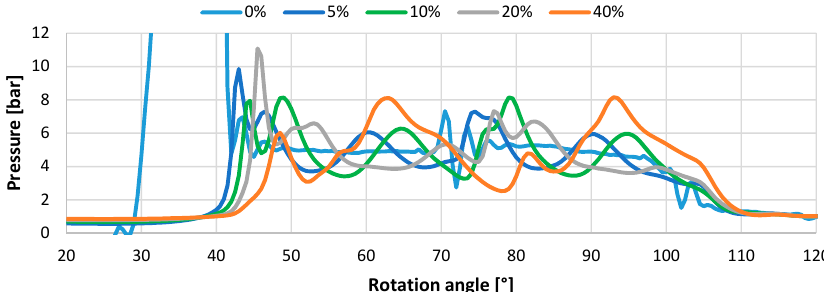
Figure 27. Instantaneous displacement chamber pressure profiles for different IGVF of free air at 5-bar delivery pressure and 2000 rpm.